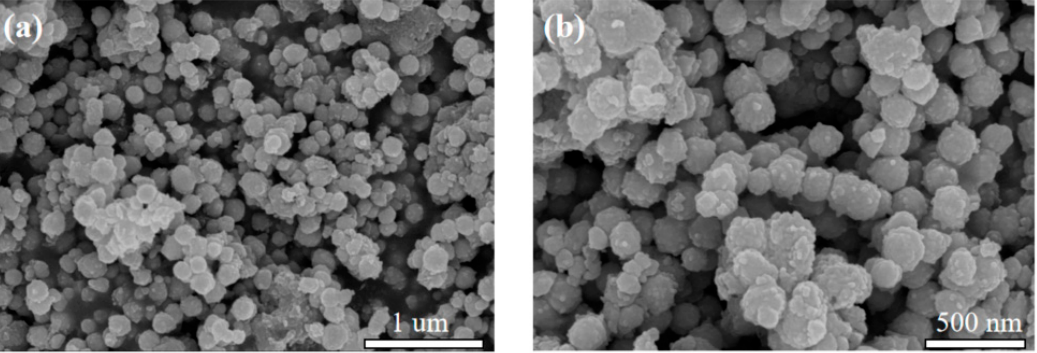
Figure 2. ( a ) Low magnification and ( b ) high magnification SEM images of FeNi 3 alloy.